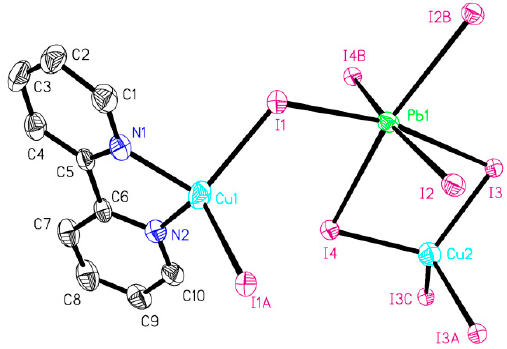
Figure 1. The coordination environment of the Pb and Cu atoms in 1 . All H atoms have been omitted for clarity. Displacement ellipsoids are depicted at the 30% probability level. Symmetry codes: A: − 1 + x , y , z ; B: 1 + x , y , z ; C: 1 − x , − y , − z .